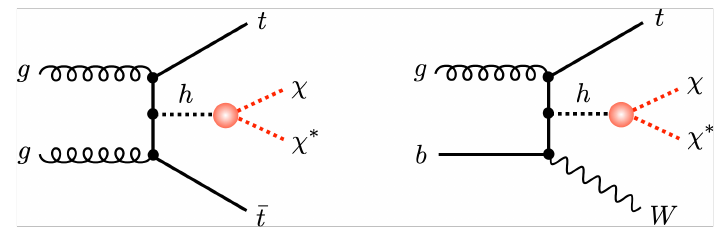
Figure 1 . Examples of diagrams with insertions of the DM-Higgs operators (filled red circles) in (2.1) that lead to a t ¯ t + E miss (left) and tW + E miss (right) signal. The black dots indicate SM T T interactions.